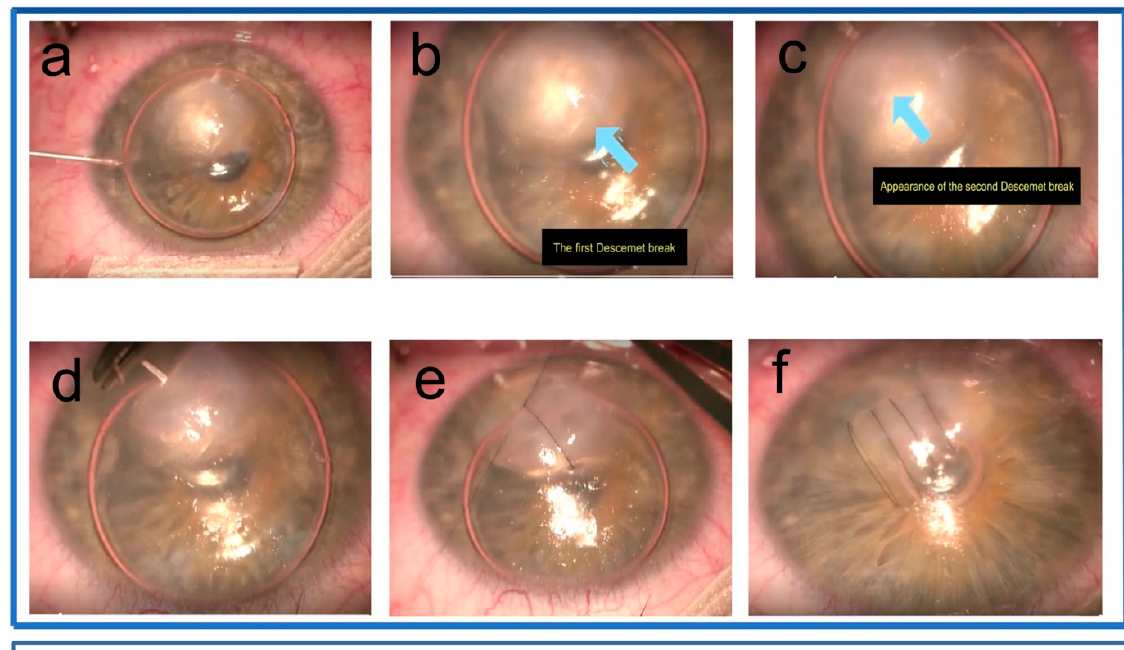
Figure 1. ( a ) Injecting the air bubble in the AC via paracentesis, ( b , c ) the appearance of two Descemet breaks, ( d ) placing the perpendicular full-thickness suture, ( e ) making the suture tight, and ( f ) four full-thickness suture perpendicular to the Descemet